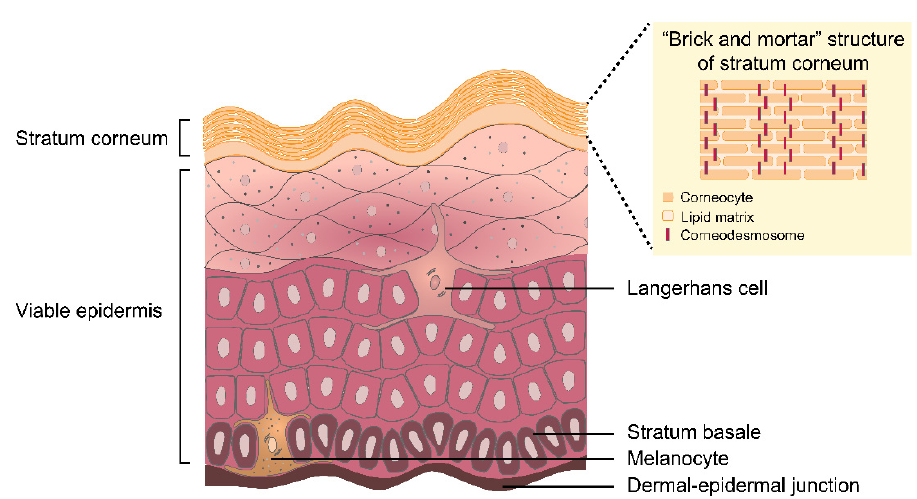
Figure 2. The location of dendritic cells (Langerhans cells and melanocytes) in the viable epidermis.